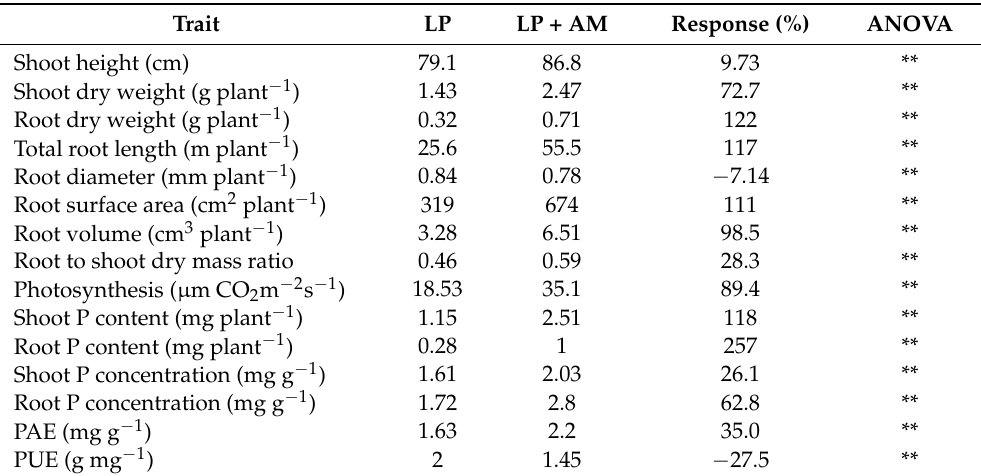
Table 2. Mean values and response (%) of 15 traits of both maize genotypes to arbuscular mycorrhizal (AM) fungus ( Funneliformis mosseae BGC NM02A) under low phosphorus (LP, no P added) conditions. Trait LP LP +